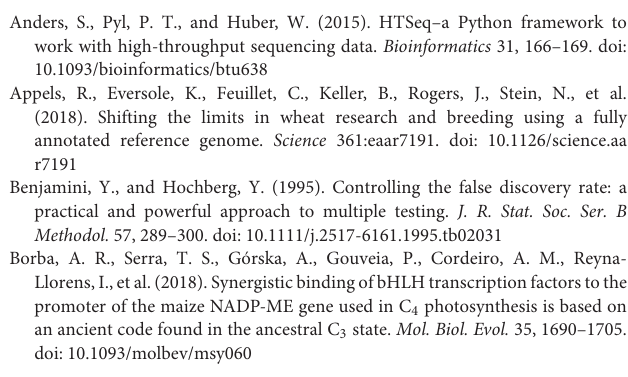
Supplementary Figure 1 | Karyotypes of the six disomic substitution (DS) lines in the FISH assay, and the red arrow represents the alien 3E and 7E chromosomes. Supplementary Figure 2 | Comparison of the number of upregulated genes and downregulated genes in DS3E and DS7E. Upregulated and downregulated genes were represented by different colors. Statistical analysis was performed using the T -test method. ∗∗∗∗ p < 1 e -5. Supplementary Figure 3 | Distribution of the differentially expressed genes (DEGs) and non-DEGs along the 3E and 7E chromosomes. (A) Distribution in the number of the DEGs and non-DEGs along the 3E and 7E chromosomes. (B) Distribution in the proportion of the DEGs and non-DEGs along the 3E and 7E chromosomes. (C) Overlapped DEGs of DS lines belonging to the same linkage group. Supplementary Figure 4 | The chromosomal spread of 7A genes showing altered transcription in DS3E(3D). The blue shadow in the 7AL terminal represents the deletion region of the wheat genome. The ratio of not-DT to transcribed genes (TGs) [R(not-DT/Trans)], the ratio of upregulated to TGs [R(Up/Trans), the ratio of downregulated to TGs [R(Down/Trans)], and the mean log FC in CS along the 7A chromosome were represented by different colors. Supplementary Figure 5 | The chromosomal spread of 7A genes showing altered transcription in DS7E(7D). (A) Deletion of the chromosomal fragment that occurs on 6BL. (B) Deletion of the chromosomal fragment that occurs on 6DL. The blue shadow represents the deletion region. The ratio of not-DT to TGs [R(not-DT/Trans)], the ratio of upregulated to TGs [R(Up/Trans), the ratio of downregulated to TGs [R(Down/Trans)], and the mean log FC in CS along the 6B and 6D chromosomes were represented by different colors. Supplementary Figure 6 | Comparison of upregulation and downregulation of homologous genes of downregulated genes in 3E and 7E. Statistical analysis was performed using the T -test method. NS , no